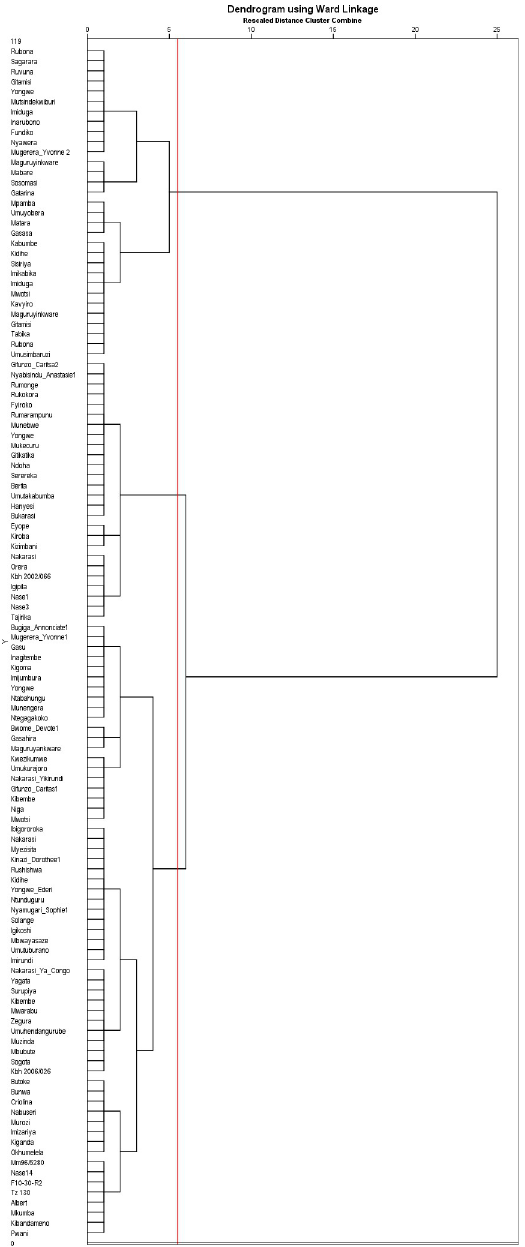
Fig 4. Phenotypic classification of cassava accessions based on the Ward’s method at a dissimilarity level of 6. level of 6. Cluster I containing 31 accessions (all local landraces) had two sub-clusters. Cluster II consisted of 26 accessions (3 sub-clusters) and was composed of local landraces and elite genotypes. Sub-cluster III of cluster II consisted of five elite genotypes; Tajirika, Nase 1, Nase 3, KBH2002/066 and Orera, and two local landraces (Nakarasi and Igipila), sub-cluster II of 3 elite genotypes namely Kizimbani, Kiroba and Eyope while sub-cluster I consisted of 16 local landraces (Fig 4). Cluster III was the largest with two sub-clusters consisting of 51 local landra- ces and ten elite genotypes. Elite genotypes under this category were KBH2006/026,